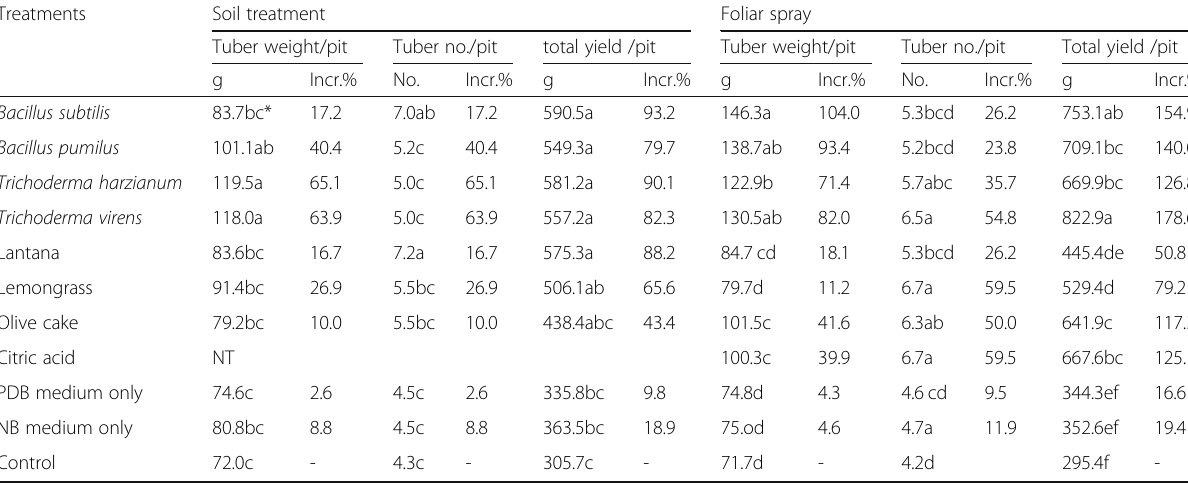
Table 3 Effect of bio-control agents, aqueous plant extracts, and citric acid as soil treatment and/or foliar spray on yield parameters of potato plants in field application